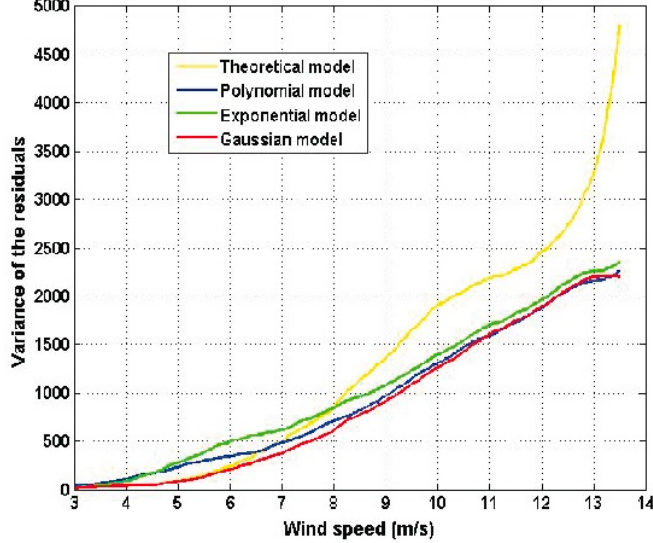
Figure 7. Variance of the residuals of the estimated models of Table 1.